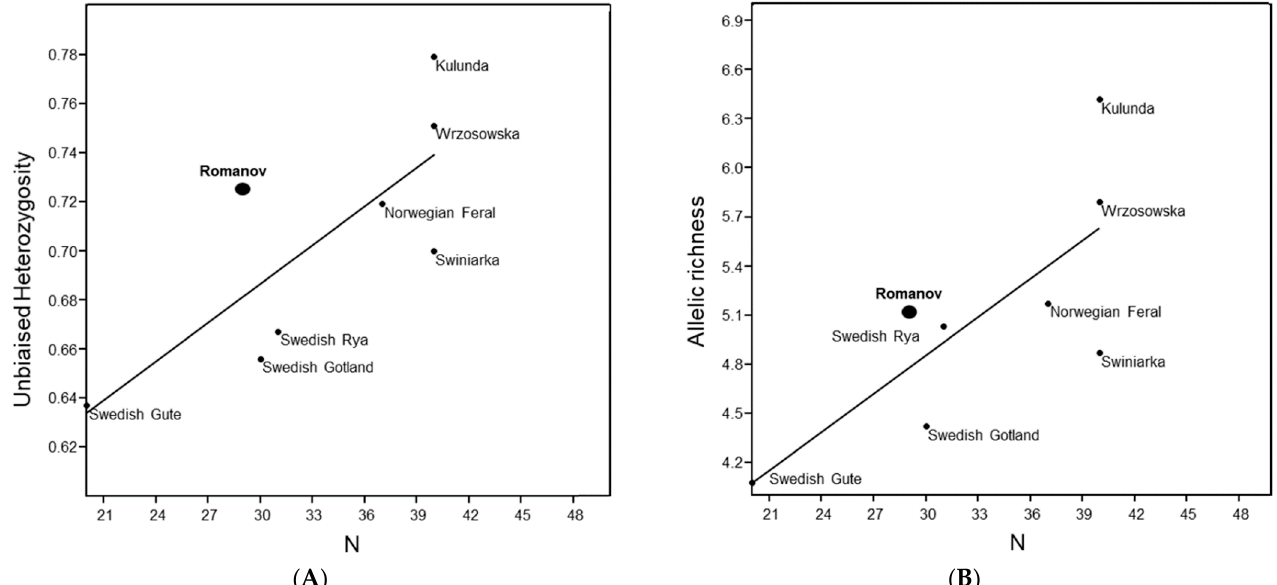
Figure 1. Genetic variability of sheep in the northwestern cluster (northwest of Russia, Poland and Scandinavia), reported to the sampling size. ( A ): Unbiased heterozygosity; ( B ): allelic richness. N = sampling size. The p -values of regressions are 0.024 and 0.028 for A and B, respectively.